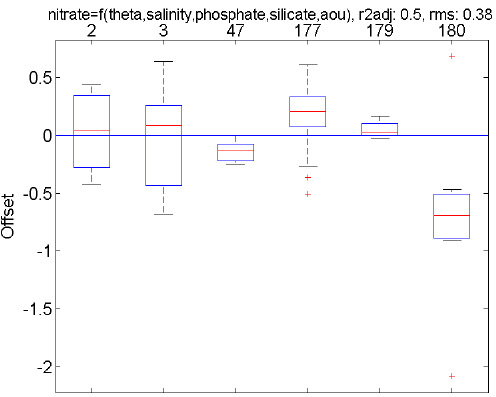
Figure 12. MLR results for NO 3 in the Nansen Basin (o ff sets in µ molkg − 1 ), calculated using adjusted AOU for